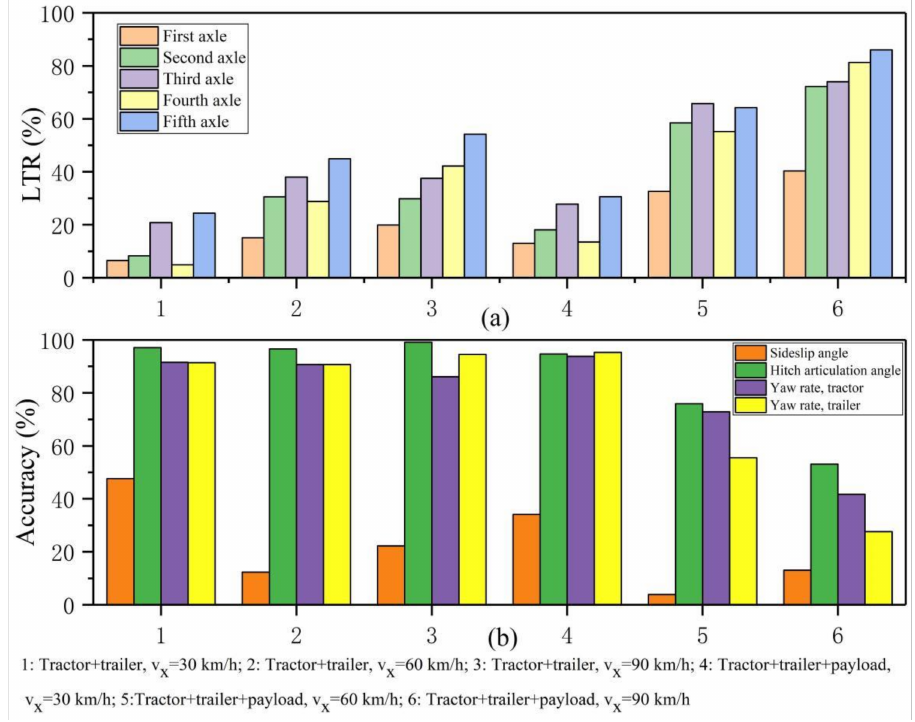
Figure 9. Accuracy of steady-state value prediction under different vehicle speeds and load conditions. ( a ) LTR. ( b )